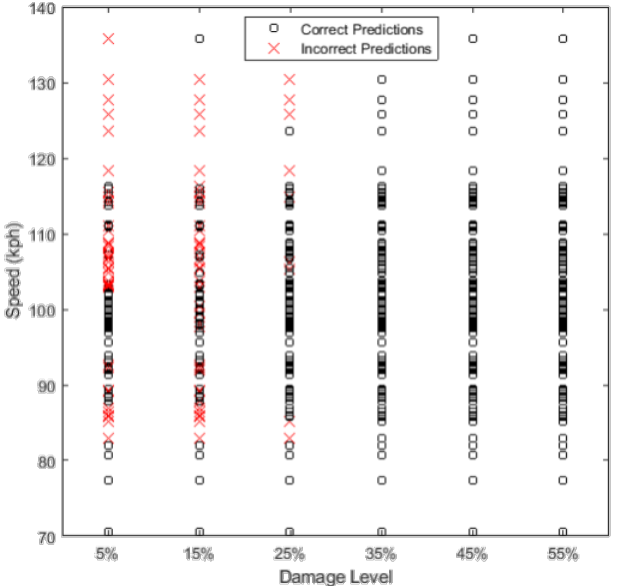
Figure 13. True-positive and true-negative predictions for trained algorithms.